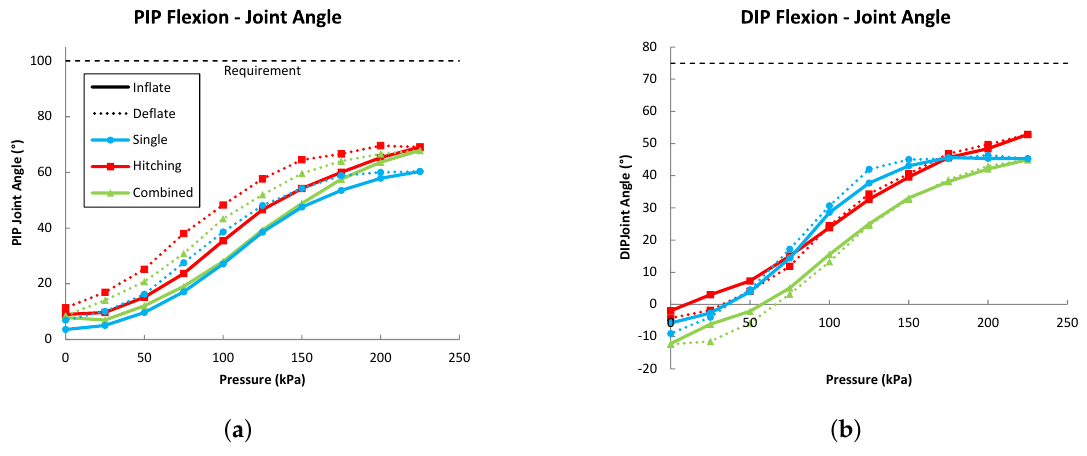
Figure 10. Motion capture measurement results for flexion of ( a ) PIP joint and ( b ) DIP joint.